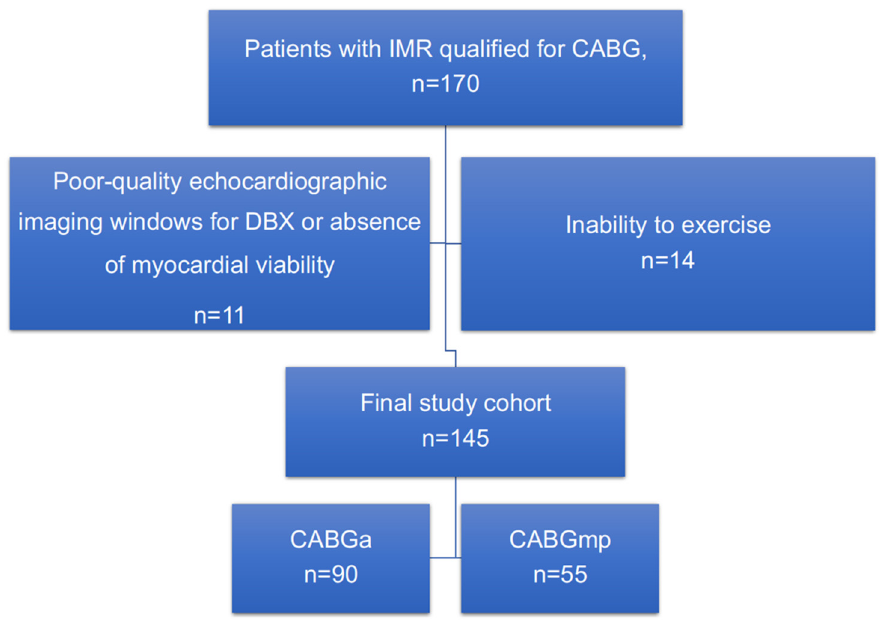
Figure 1. Study flowchart. CABG—coronary artery bypass grafting; DBX—dobutamine stress echocardiography. Table 1. Eligibility criteria to a given type of surgery. CABGa CABGmp